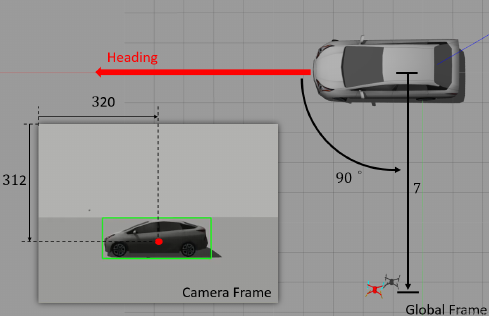
Figure 6. The red dot inside the bounding box represents the reference feature vector as defined in (21) and is used in the simulation as prescribed by the